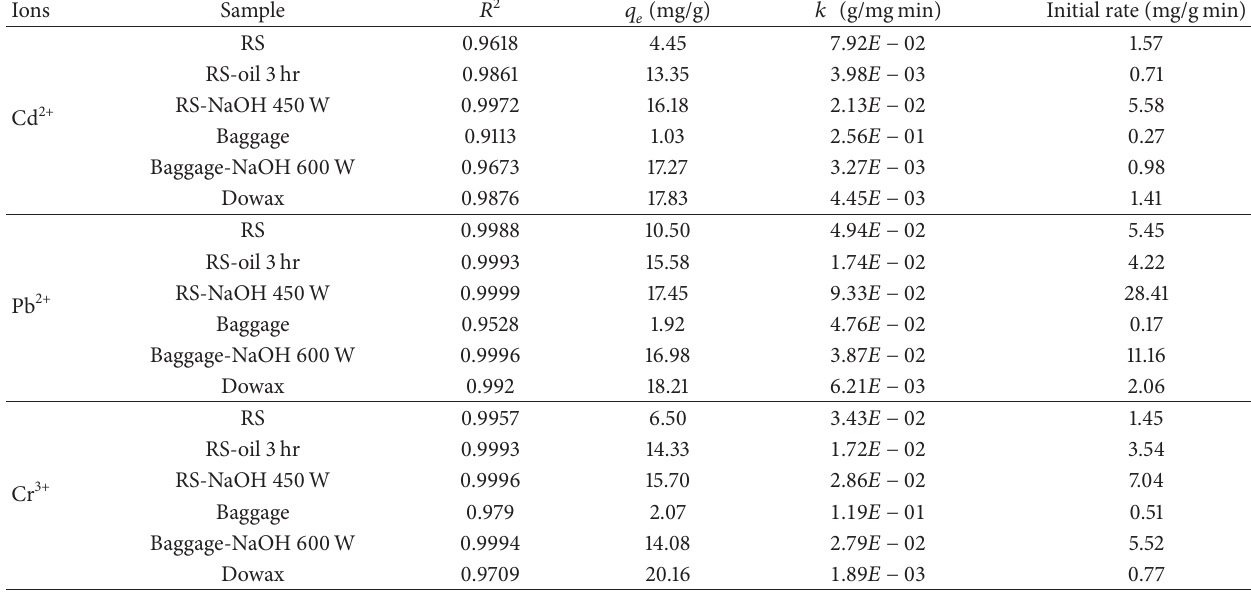
Table 5: Parameters form fits to the pseudo-second-order